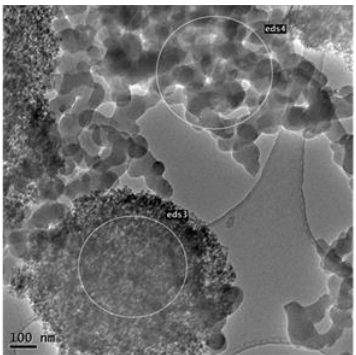
Figure 5. TEM images recorded for reduced Co/SiO 2 catalyst after reaction under batch reaction and EDS analysis.